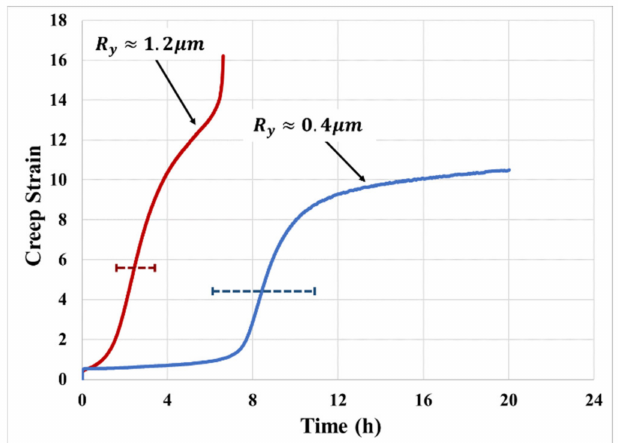
Figure 7. Effect of surface roughness on the creep responses of PSA bonded with aluminum substrate with different surface roughness (130 µ m thick